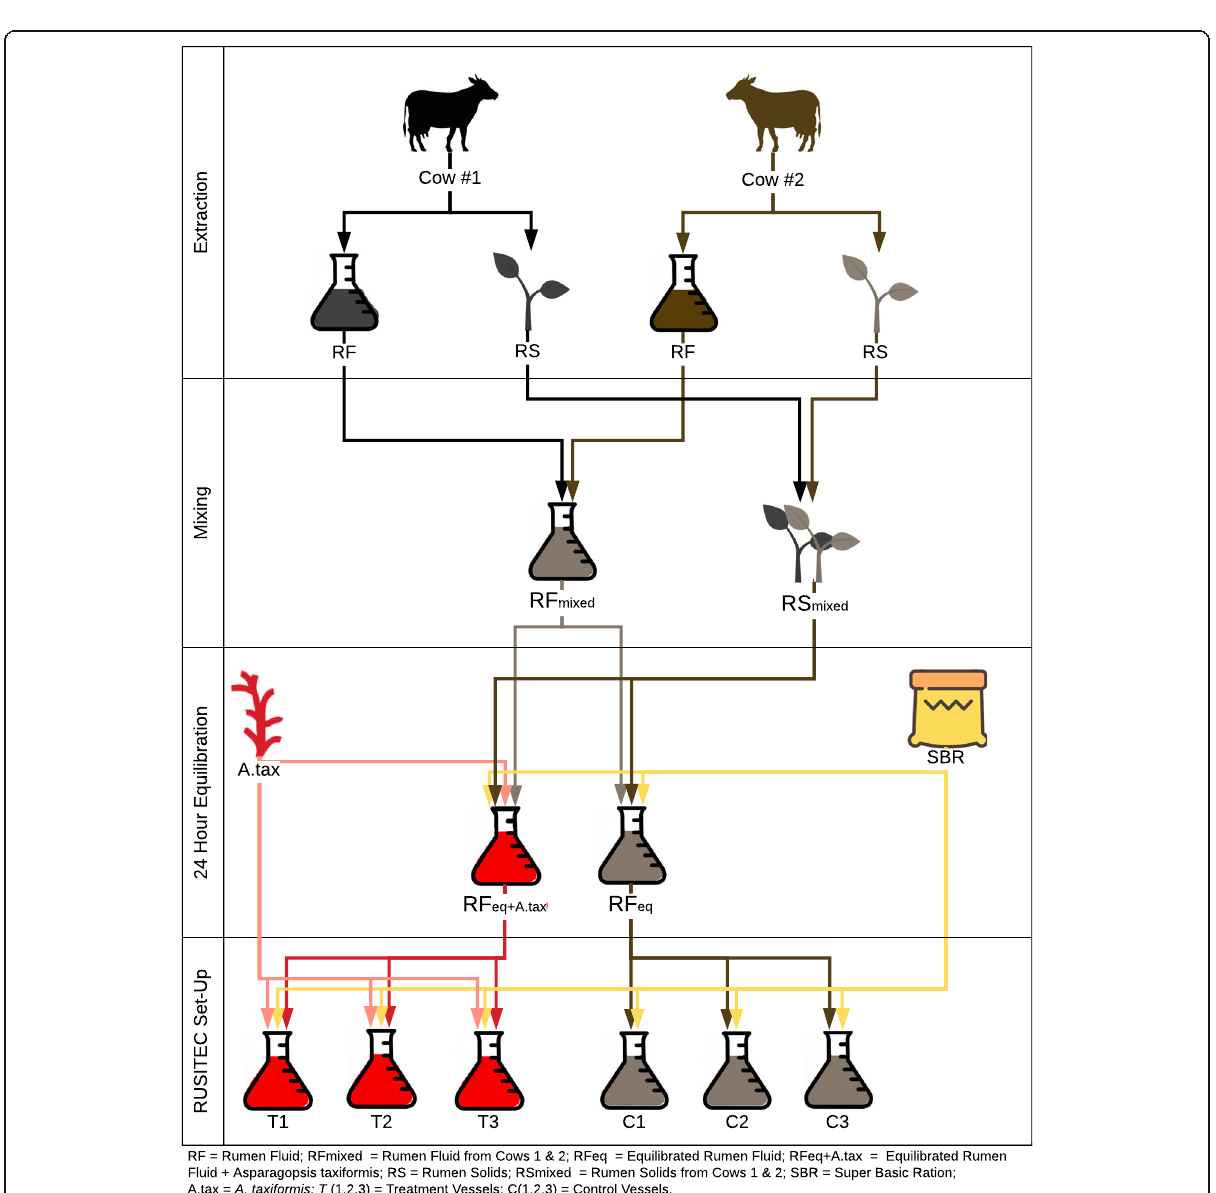
Fig. 1 In-vitro rumen system set-up. Extraction: Rumen fluid and rumen solids were collected from 2 dairy cows. Mixing: Rumen fluid was homogeneously mixed and rumen solids were homogeneously mixed. After mixing, rumen fluid was separated into two Erlenmeyer flasks, where treatment was then assigned. 24 Hour Equilibration: The control flask received 30 g of mixed rumen solids and 30 g of SBR and the treatment flask received 30 g of mixed rumen solids, 30 g of SBR, and 1.5 g of A. taxiformis . After each flask received their treatment, the 24 h equilibration period began. After the equilibration period, each flask was then divided into 3 vessels, then fed their respective treatments (control = 10 g SBR/ vessel, treatment= 10 g SBR/vessel & .2 g A. taxiformis